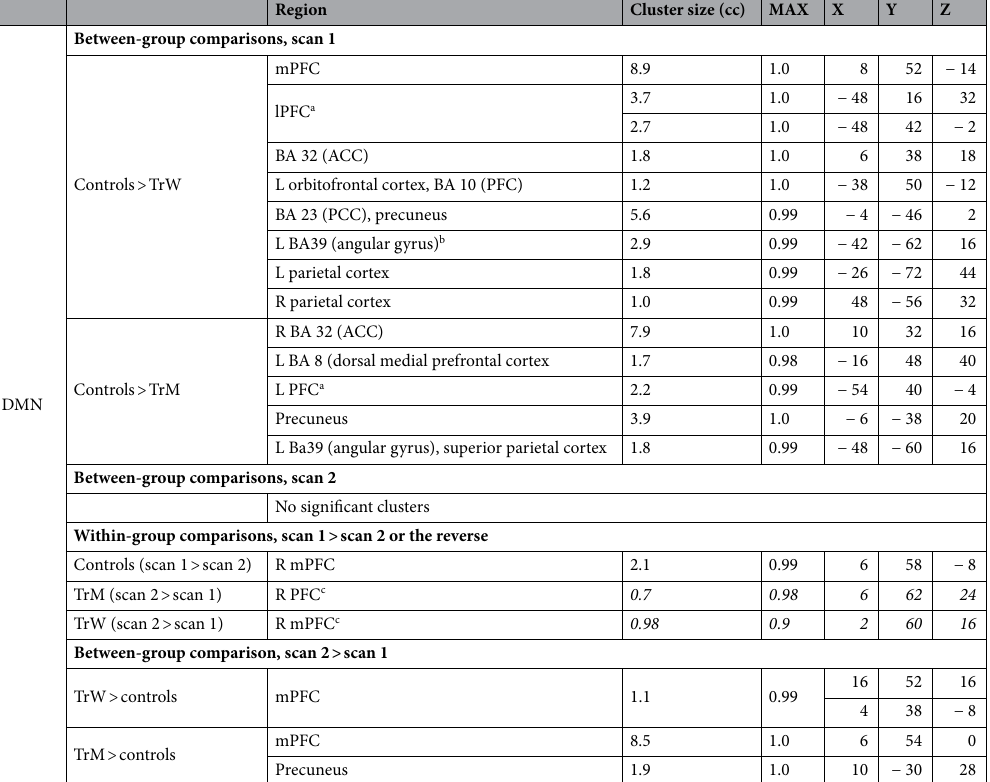
Table 3. Connectivity in DMN before (scan 1) and after (scan 2) cross-sex hormone treatment in TR persons, (no treatment in controls). DMN, default mode network; mPFC, Mesial prefrontal cortex; lPFC, Lateral prefrontal cortex; ACC, Anterior cingulate cortex. Calculations at 1 − p > 0.98, cluster size > 1.0 cc; Italics indicate sub-significant clusters (1 − p < 0.98, cluster size < 1.0 cc). The CON < TrM and TrW clusters in anterior DMN could be partly constituted by lower connectivity in scan 2 vs 1 among controls, in addition to the increased connectivity in TrM and TrW in scan 2 vs 1. Scan 2 > 1 in the posterior DMN are constituted by scan 2 increases among the transgender group. a Includes part of the dorsolateral prefrontal cortex. b Includes superior parietal cortex. c Indicate sub-significant levels (cluster size < 1.0 cc), none of the other contrasts showed any